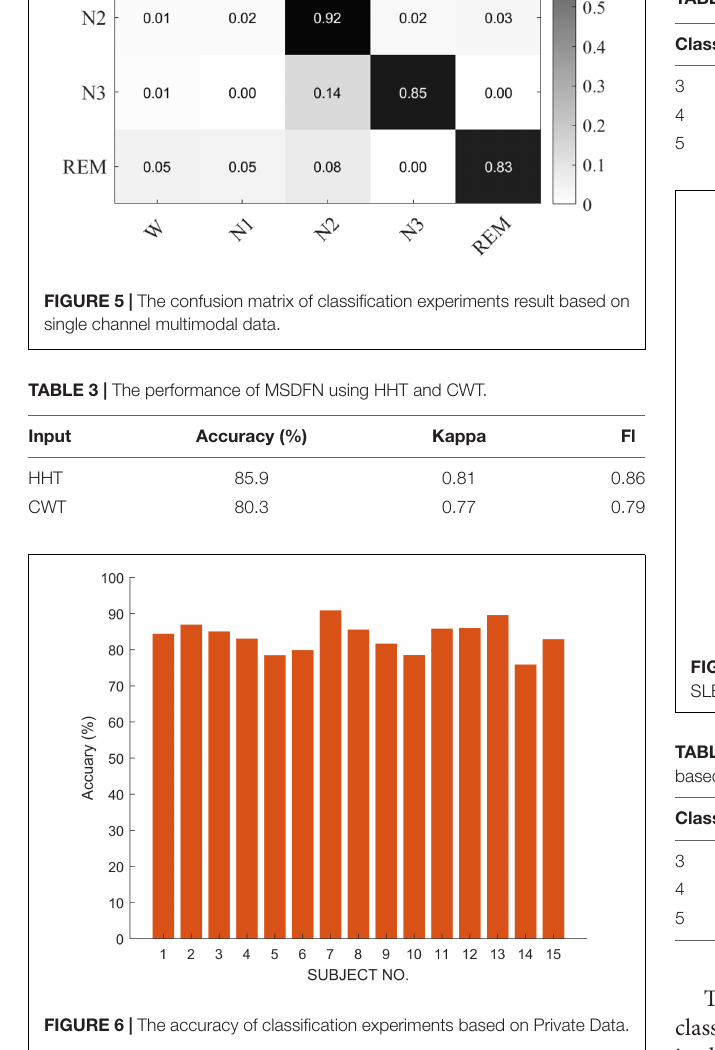
TABLE 5 | The details of categories in multi-classification experiments.